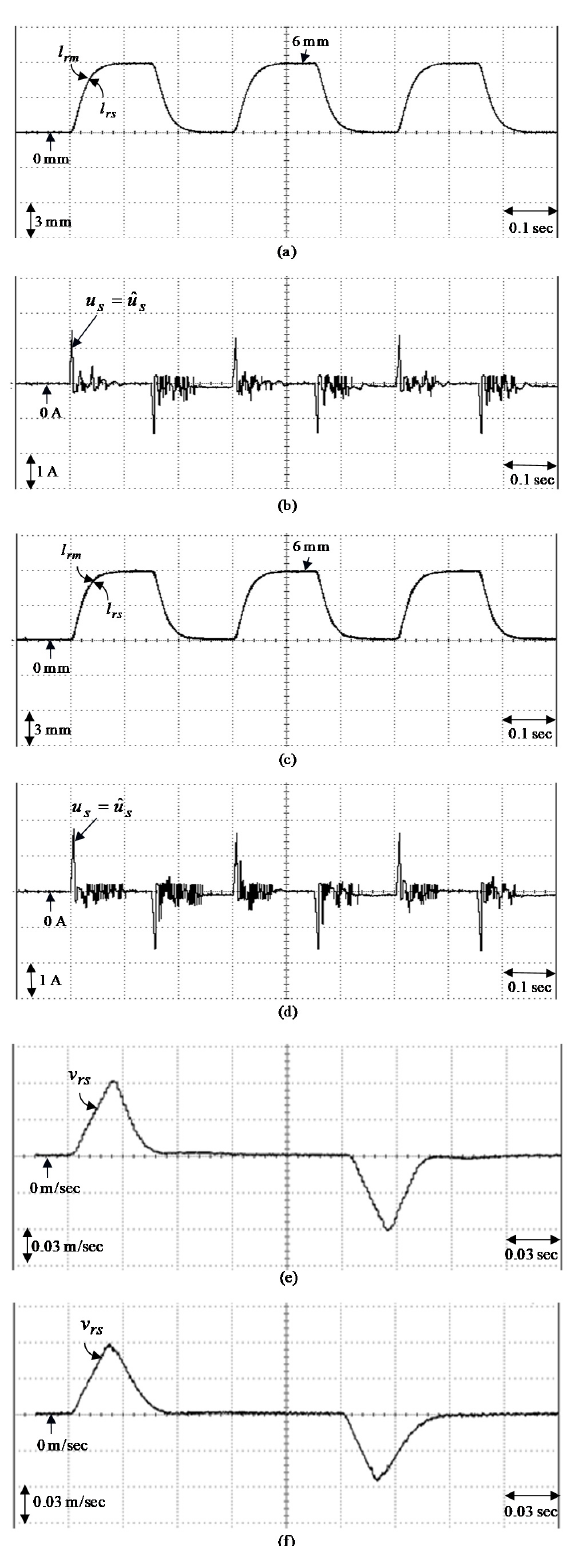
Figure 12. Tested results utilized by the control system K3: ( a ) mover position response at Situation Q1, ( b ) control propulsion response at Situation Q1, ( c ) mover position response at Situation Q2, ( d ) control propulsion response at Situation Q2, ( e ) mover velocity response at Situation Q1, ( f ) mover velocity response at Situation Q2.